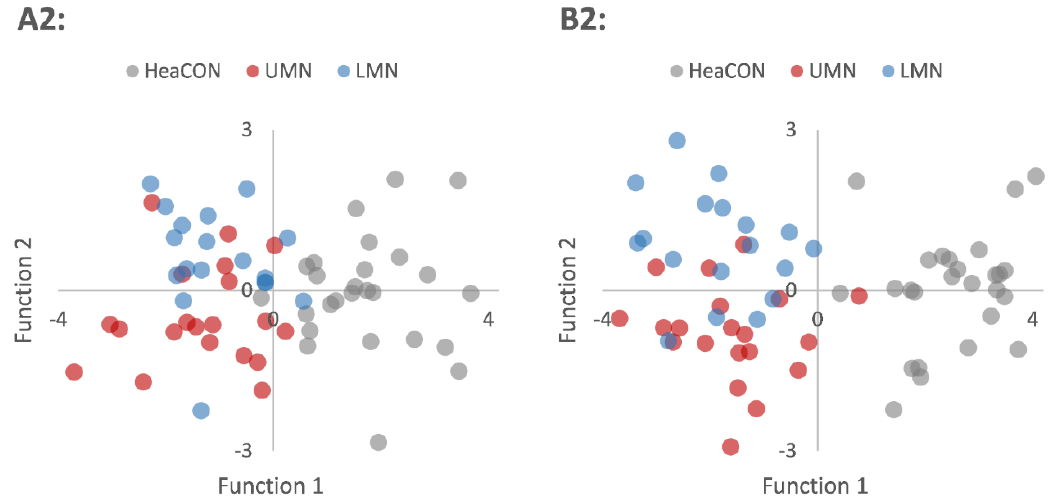
Figure 3. Functions of discriminant analyses. Discriminant functions for distinguishing between UMN, LMN and HeaCON based on the cortical thicknesses of either the precentral gyrus, inferior temporal gyrus and temporal pole ( A2 ) or the precentral gyrus, temporal pole, lateral orbitofrontal gyrus, lingual gyrus and entorhinal cortex ( B2 -stepwise). HeaCON, healthy controls; LMN, lower motor neuron patients; UMN, upper motor neuron patients.